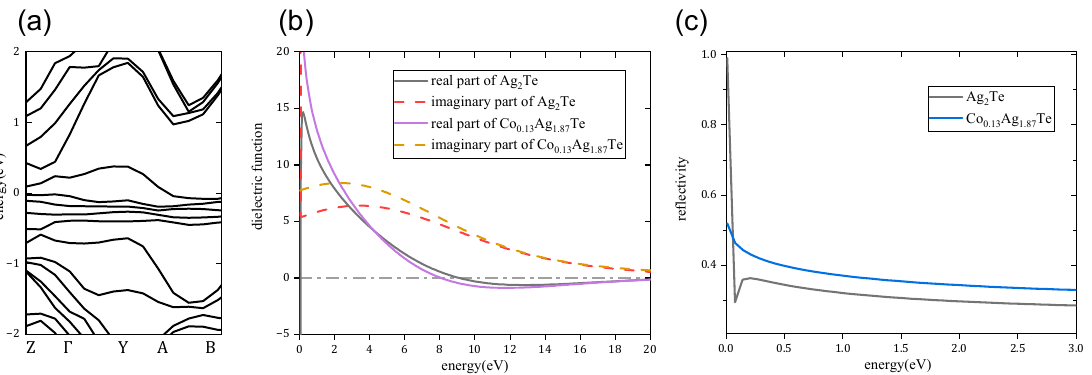
Figure 4. Electronic structure and optical properties for Ag 2 Te and Co 0.13 Ag 1.87 Te. ( a ) Band structures of Co 0.13 Ag 1.87 Te. ( b ) Calculated dielectric function of Co 0.13 Ag 1.87 Te. The solid line represents the real part of the dielectric function, and the dashed line represents the imaginary part. ( c ) Reflectivity function for Ag 2 Te and Co 0.13 Ag 1.87 Te. Table 1. Lattice constants after different types of doping.